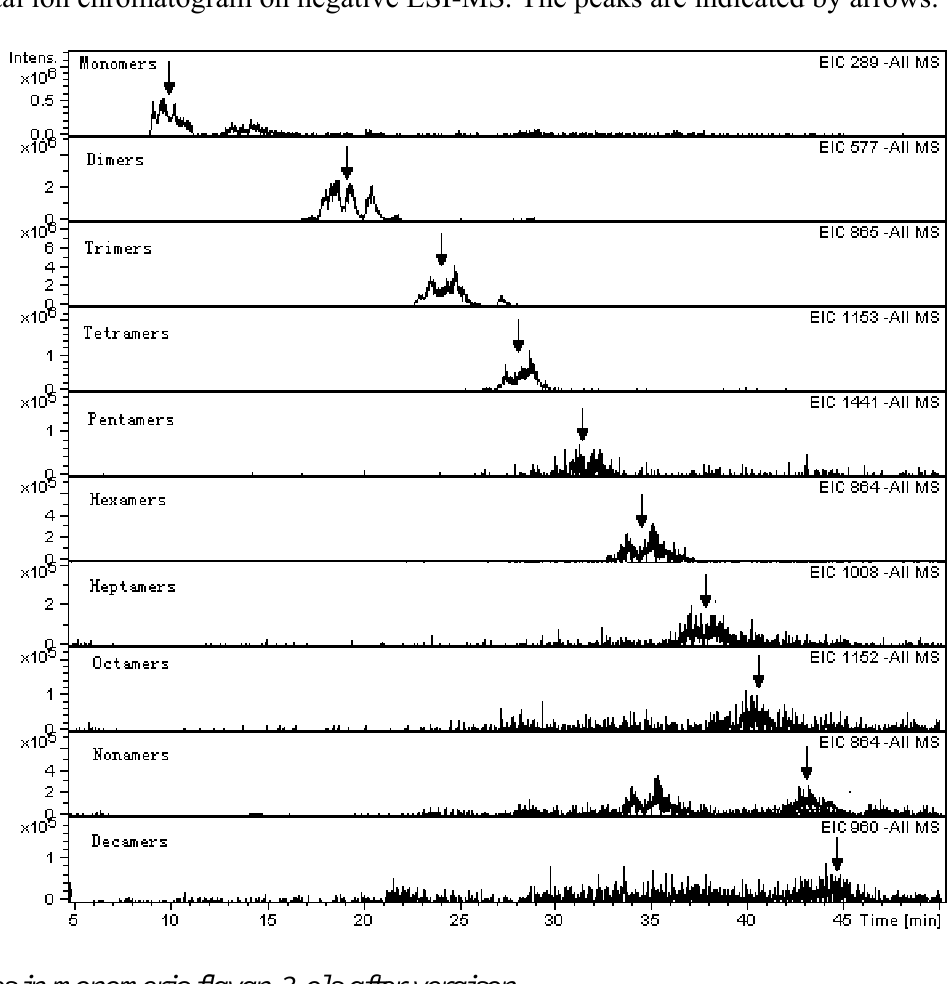
Figure 2. Extracted ion chromatogram of non-galloylated flavan-3-ol (DP = 1 ～ 10 ) from the total ion chromatogram on negative ESI-MS. The peaks are indicated by